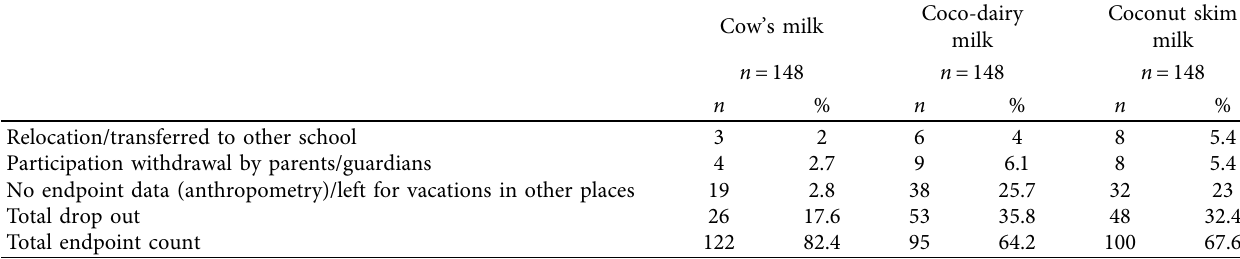
Table 2: Distribution of dropouts by